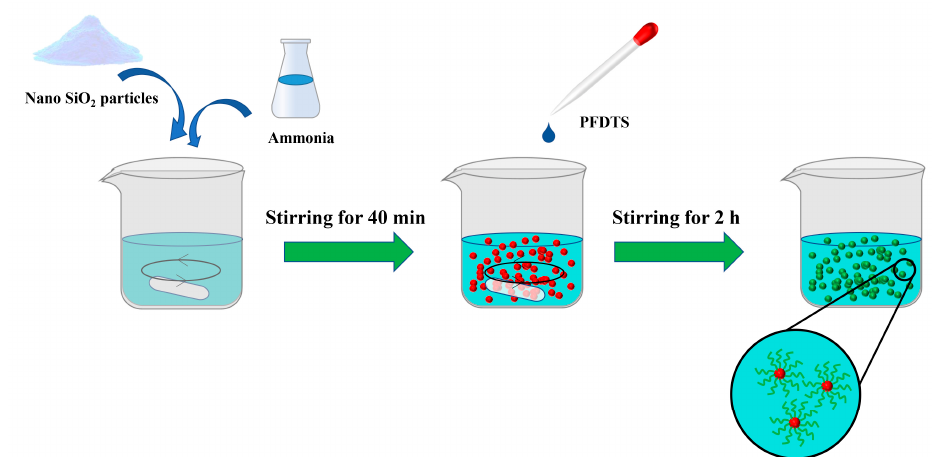
Figure 1. Preparation process of alcoholic solvents.